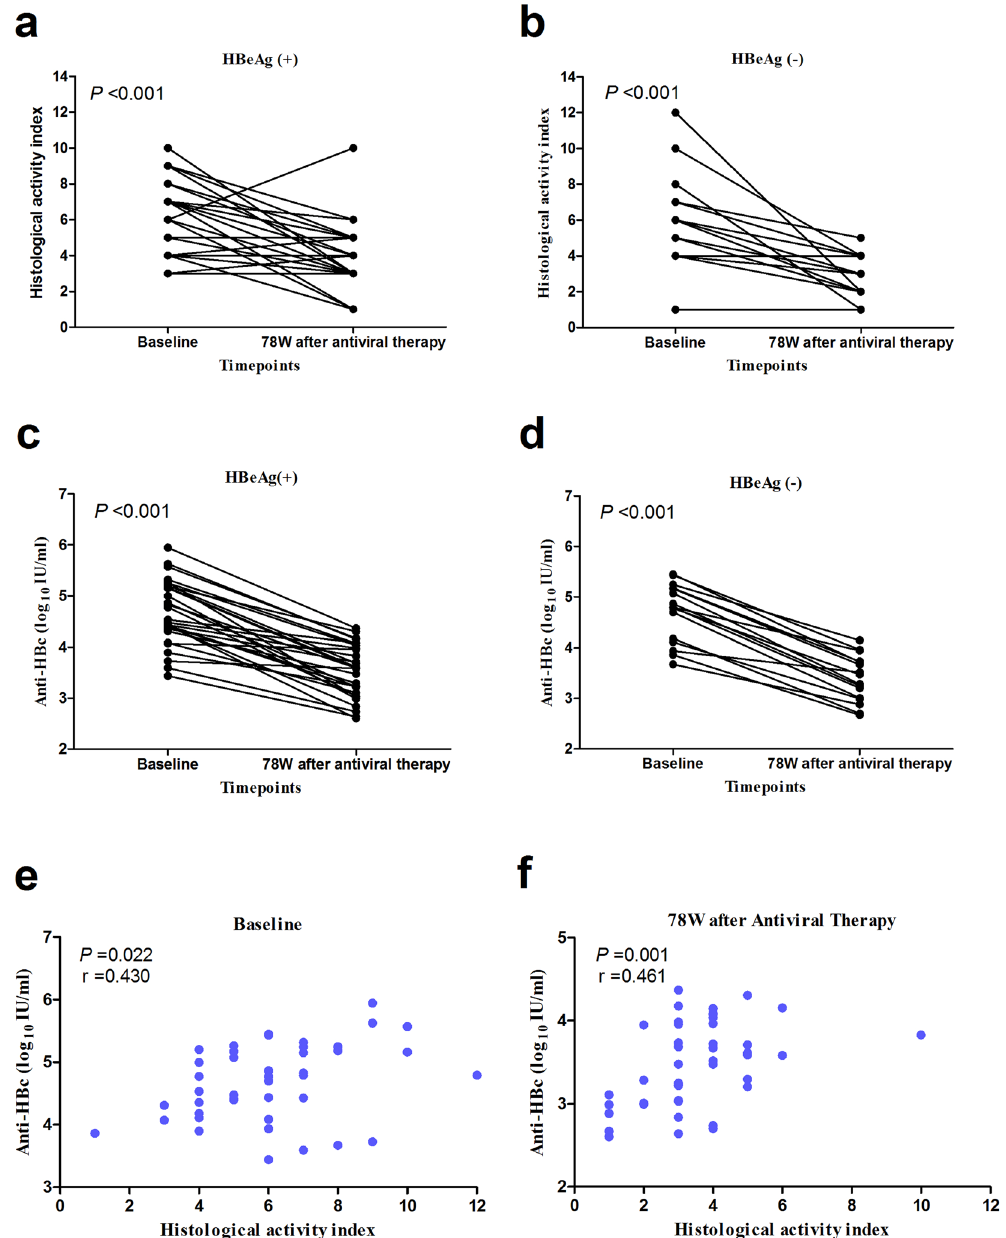
Figure 2. The level of serum anti-HBc decreased along with alleviated histological inflammation in CHB patients receiving antivirus treatment. Dynamic changes of histological activity index score in HBeAg ( + ) ( a ) and HBeAg ( − ) ( b ) CHB patients receiving antiviral treatment after a second liver biopsy. Dynamic changes of serum anti-HBc levels in HBeAg ( + ) ( c ) and HBeAg ( − ) ( d ) CHB patients receiving antiviral treatment after a second liver biopsy. The correlation between serum anti-HBc levels and HAI score in the baseline ( e ) and 78th week time point ( f